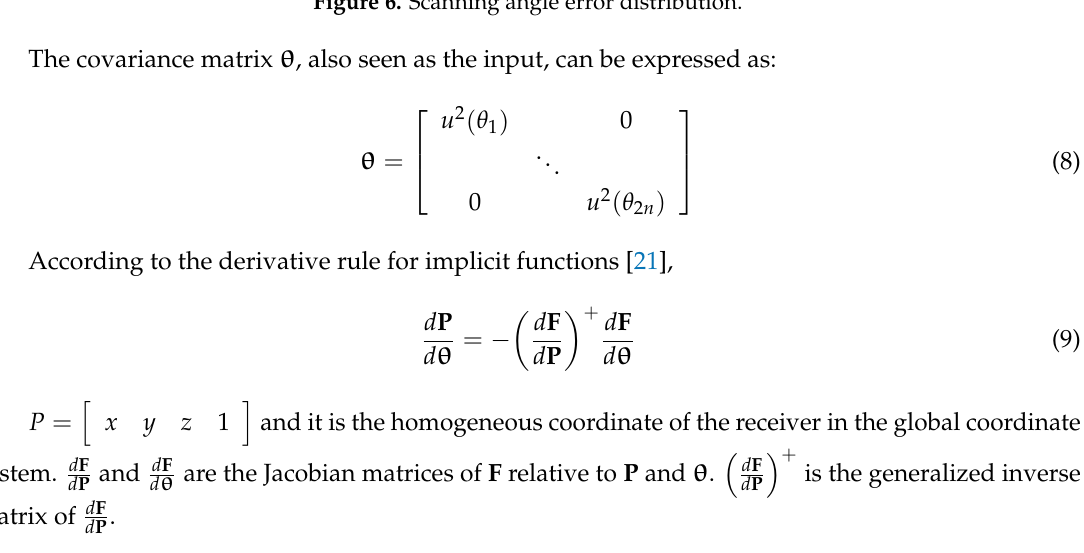
Figure 6. Scanning angle error distribution.